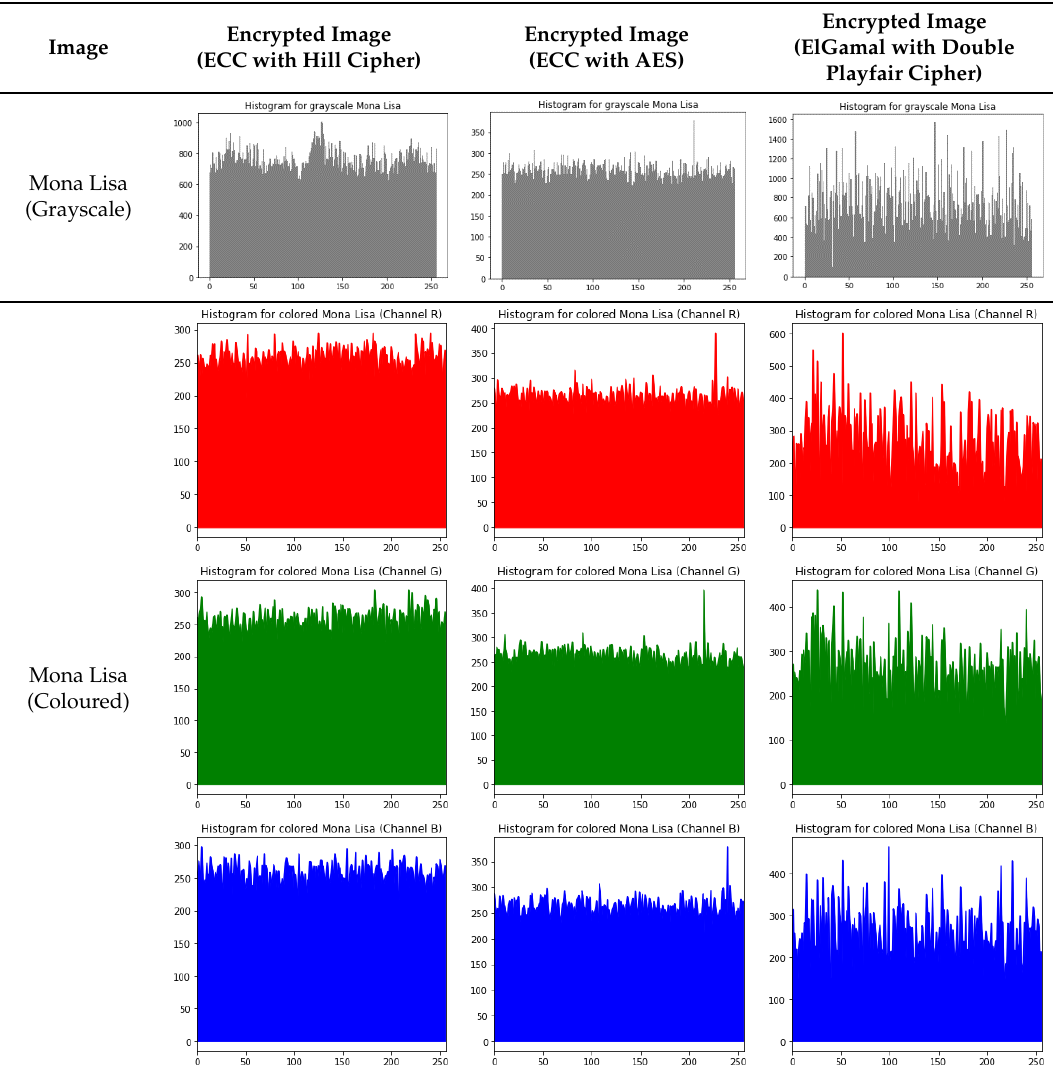
Table 6. Histogram analysis for encrypted image (Mona Lisa) using hybrid algorithms.